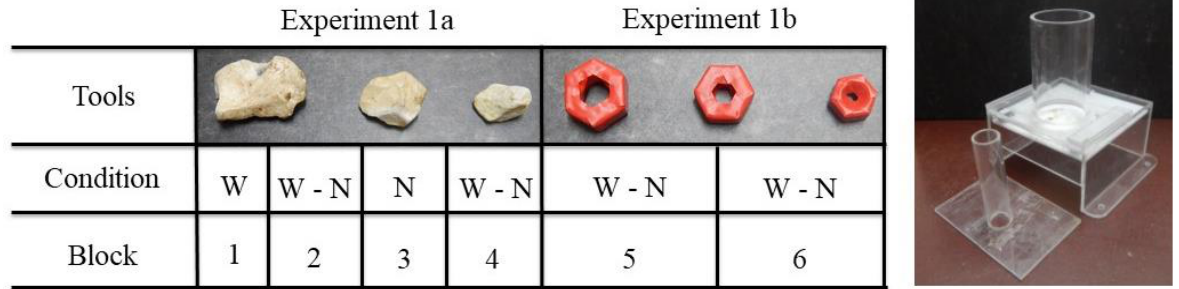
Note . Left panel) Scheme showing the tools (stones or novel objects) and conditions (Wide tube, W; Narrow tube, N) used in each block (20 consecutive trials) in Experiment 1a and 1b; Right panel) Picture of the Wide tube apparatus (back) and Narrow tube